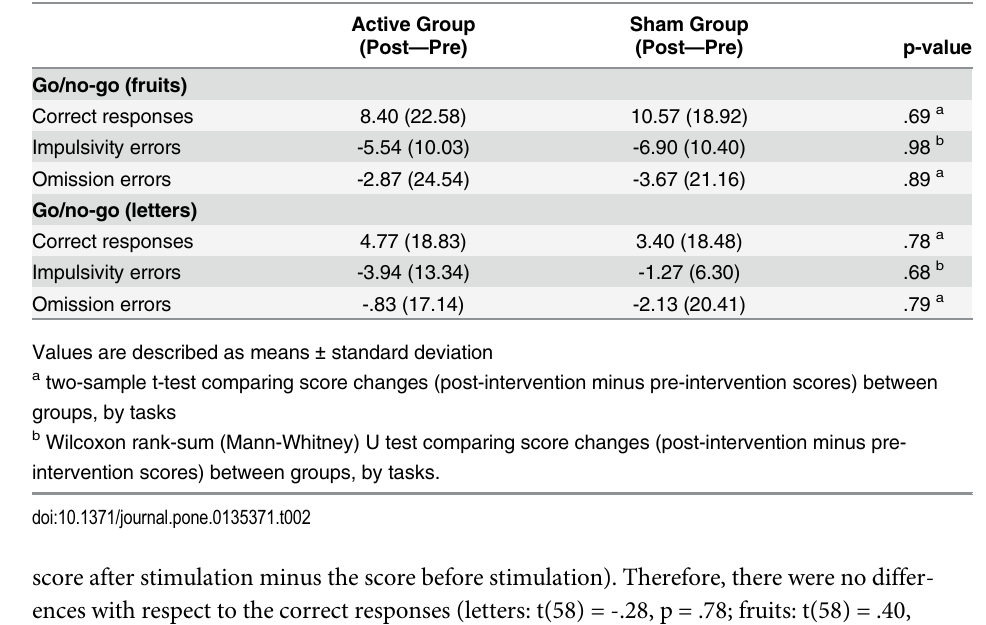
Table 2. Performance on go/no-go